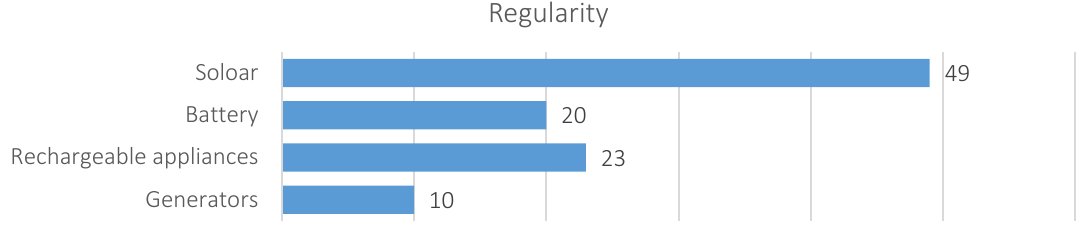
Figure 3. Ratings on